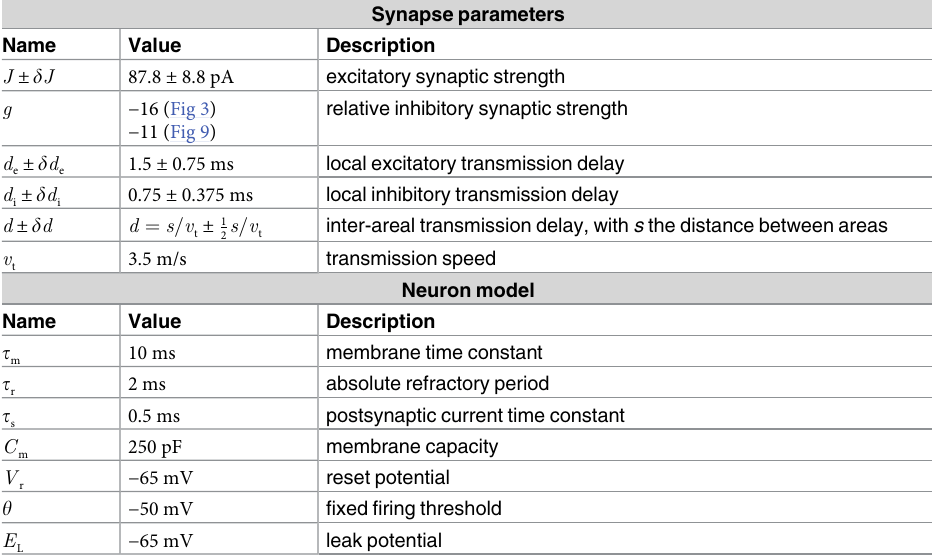
Table 1. Specification of the neuron and synapse